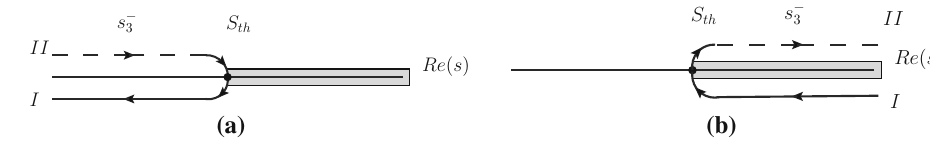
Fig. 2 The trajectory of the anomalous threshold s − : a all particles are stable; b the kinematics from Eq. (15)